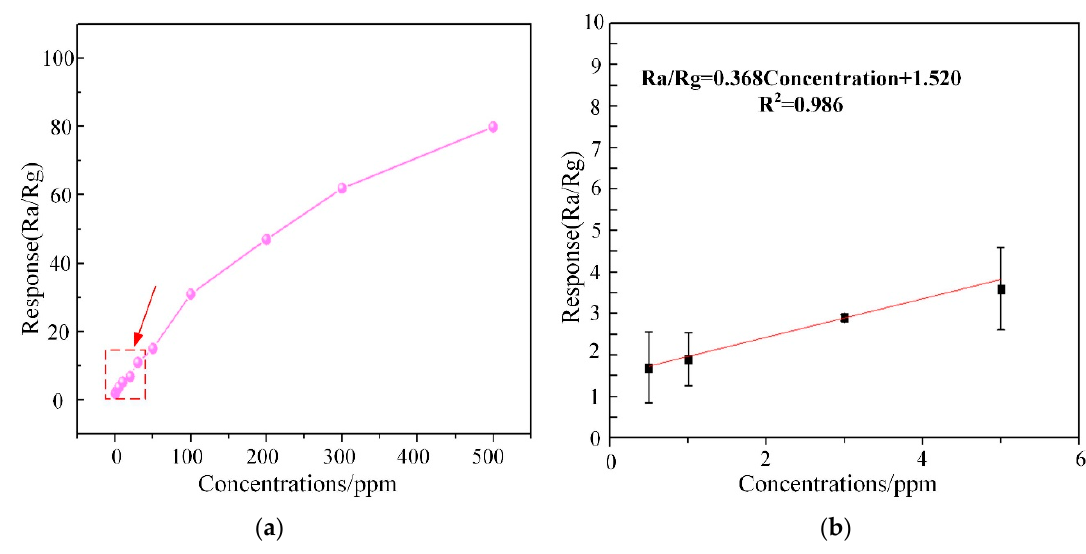
Figure 12. ( a ) Corresponding response variations of the WG1 sensor as a function of C 2 H 2 gas concentrations at 150 °C; and, ( b ) Linear relationship between response and concentrations at low concentrations.